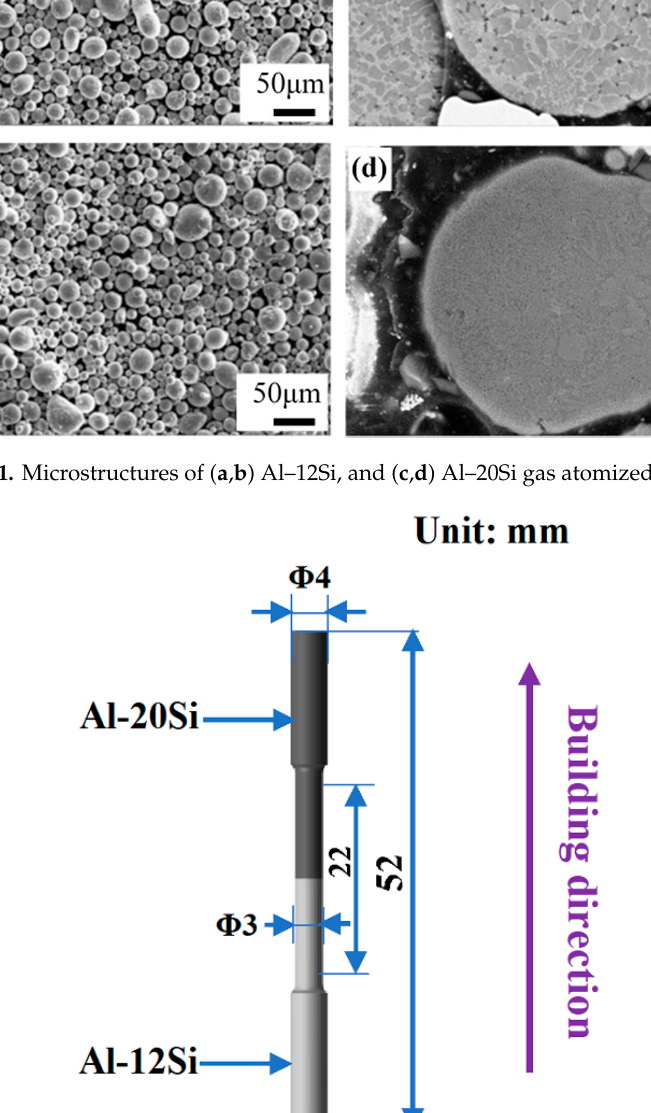
Figure 1. Microstructures of ( a, b ) Al–12Si, and ( c, d ) Al–20Si gas atomized powders.